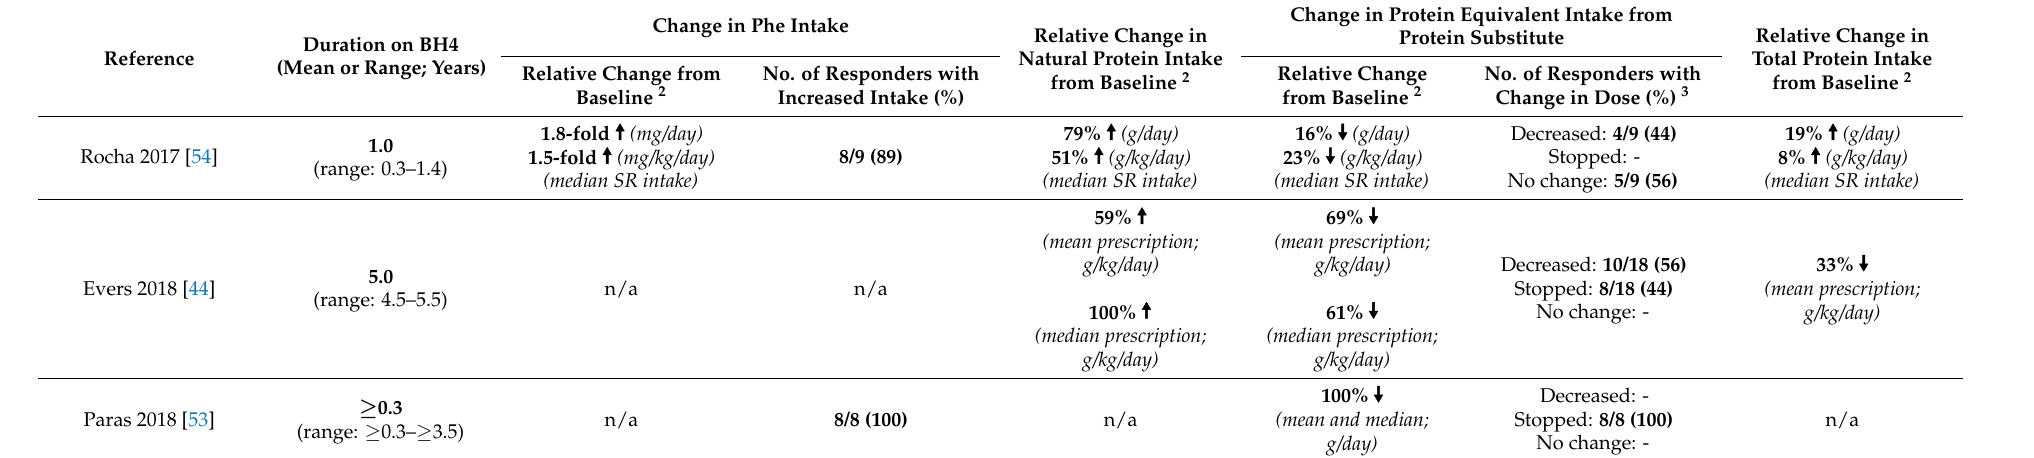
Table 2. Overview of study results: changes in phenylalanine and protein intakes (total protein, natural protein, and protein equivalent from protein substitute) of long-term responders on tetrahydrobiopterin (BH4) treatment 1 .